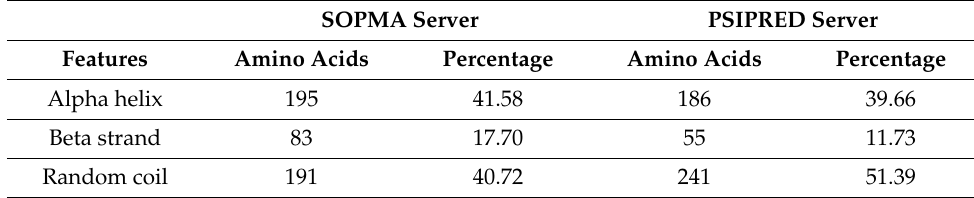
Table 5. The secondary structure of the vaccine construct.